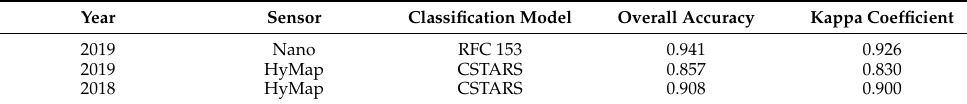
Table 3. HyMap and Nano Classification Performance by Year.